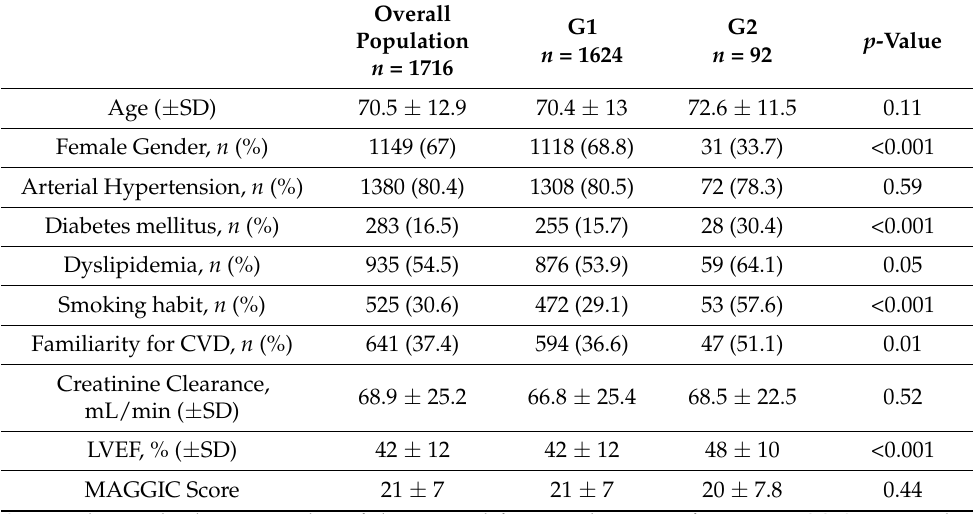
Table 1. Overall baseline